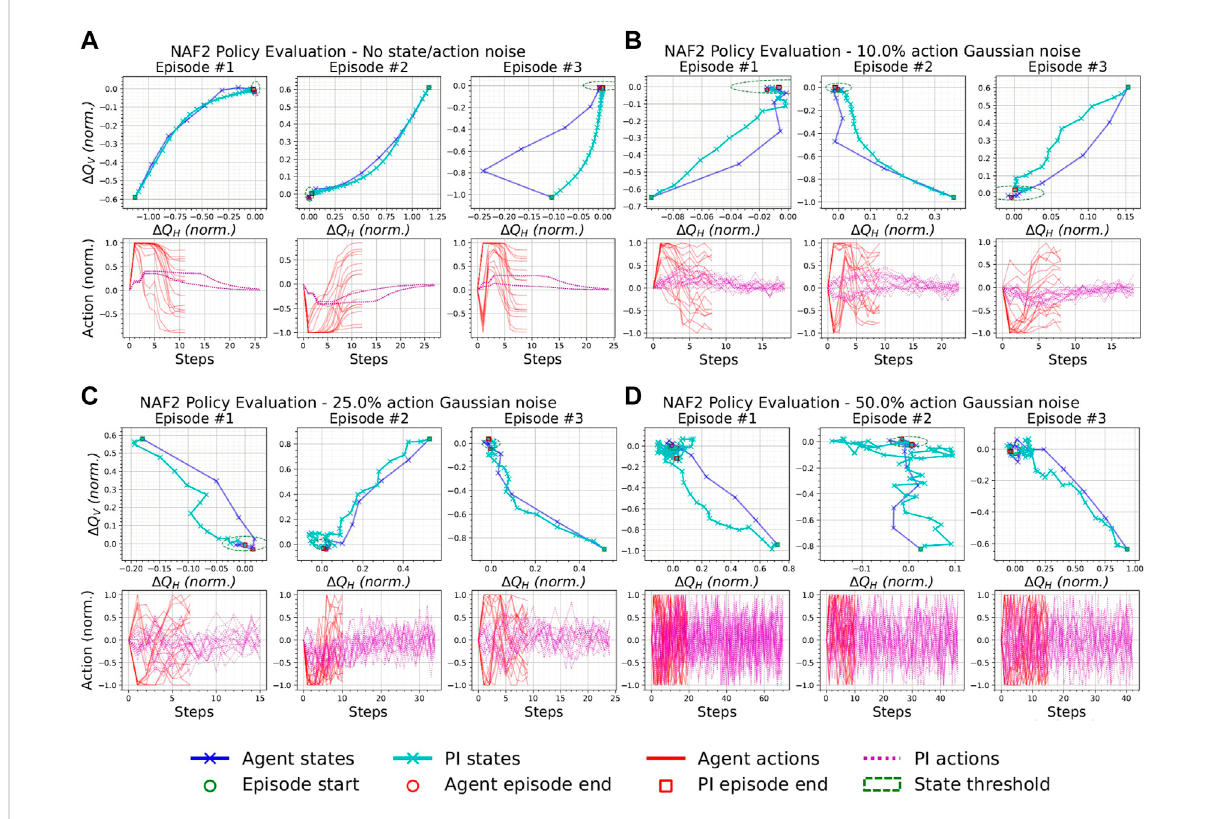
FIGURE 4 Episodes from the best NAF2 agent and the PI controller with the same initial states and with a varying additive Gaussian action noise with zero mean and standard deviation as a percentage of the half action space [0, 1]. (A) 0%, (B) 10%, (C) 25%, and (D) 50% Gaussian action